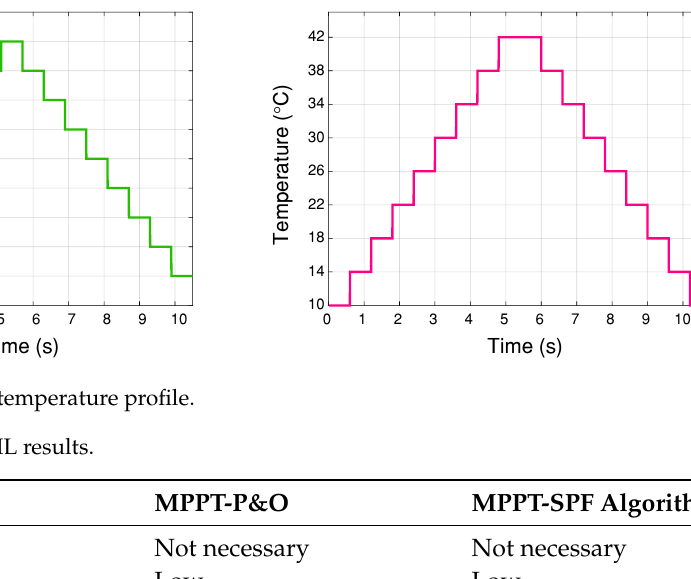
Figure 9. Simulated ( a , c ) and experimental ( b , d ) dynamic behavior of the MPPT algorithms dealing with sudden changes in irradiance between 1000 W/m 2 and 500 W/m 2 and vice versa. output voltage V o = 36 V. The proposed MPPT algorithm (top) is compared with perturb and observe (P&O)-based MPPT algorithm (bottom). CH1: v g (14 V/div), CH2: i L (4.5 A/div), CH3: Maximum power (20 W/div), CH4: Measured power (20 W/div) and a time base of 350 ms.